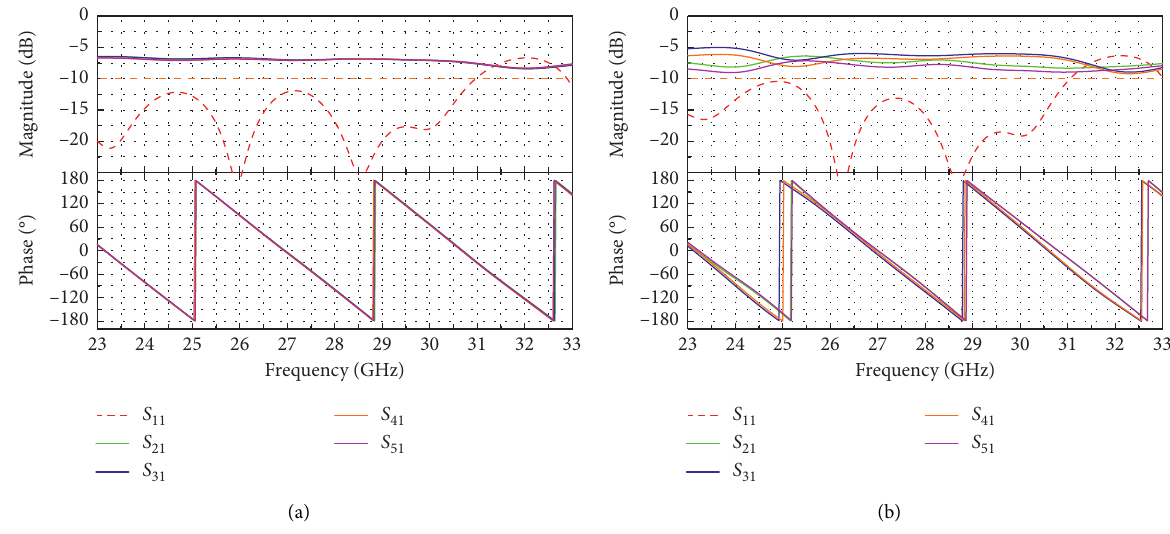
Figure 7: Simulated S-parameters of four-way power divider: (a) FC power divider; (b) UA power The simulated radiation patterns of the proposed array at 31 GHz with FC feeding network and UA feeding network